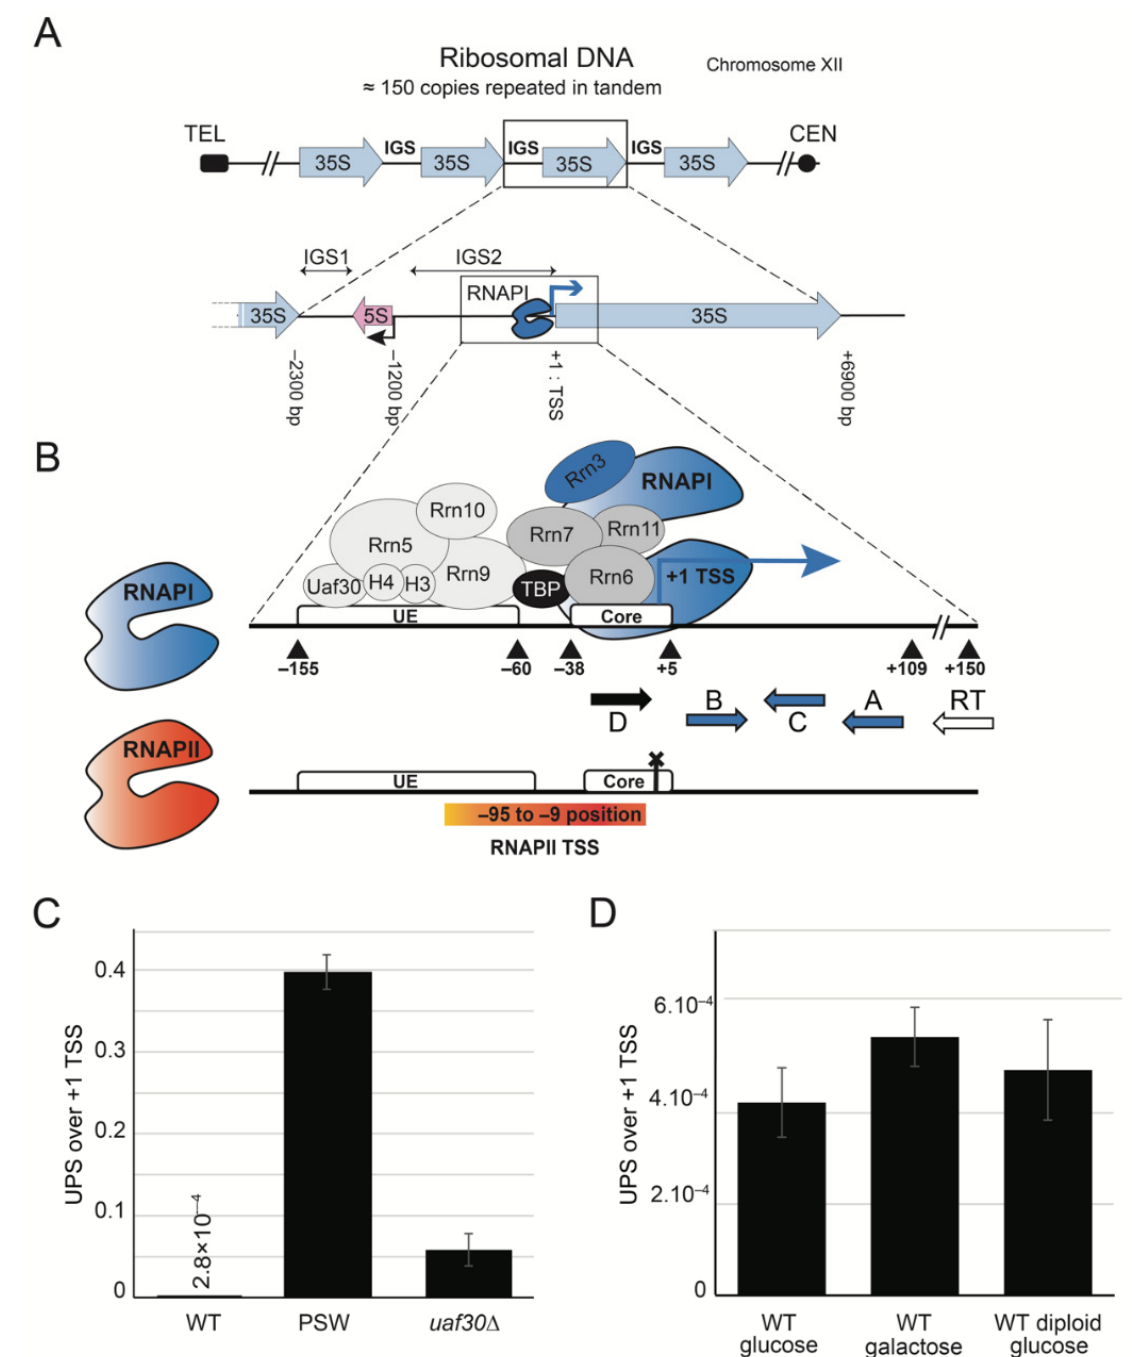
Figure 1. UPS lncRNAs are transcribed from the IGS2 region in rDNA. ( A ) Schematic representation of the rDNA locus in yeast Saccharomyces cerevisiae . The budding yeast contains a single rDNA cluster organized as a linear array of 100–150 rDNA repeats on chromosome XII. Each repeat, of 9.1-kb, produces a 35S precursor rRNA (35S gene is the blue arrow, sequence coordinates are relative to +1 TSS). IGS (intergenic sequence) is separated by the 5S gene (transcribed by RNAPIII, red arrow) into IGS1 and IGS2. ( B ) Details of the 35S promoter region composed of UE (Upstream Element) and core promoter. UE is occupied by the UAF complex (Uaf30, Rrn5, Rrn9, Rrn10, H3, and H4 subunits represented as light grey ovals). Core promoter is occupied by the Core Factor (CF) complex (Rrn6, Rrn7, and Rrn11 represented as grey ovals). UAF and CF are connected by TBP (black ovals). RNAPI bound to Rrn3 (in blue) binds CF bound to the promoter to form the pre-initiation complex. Primers used in experiments are represented below; RT forward primer was used for primer extension and reverse transcription, A-B and C-D couples were used in qPCR. Putative RNAPII (in red) promoter region ( − 95/ − 5) overlapping UE and core is represented as an orange rectangle. ( C ) UPS accumulated in PSW and uaf30 ∆ strains and are present at a very low level in wild-type strain. 1 μ g of total RNA was used for reverse transcription using RT primer. cDNAs were quantified by qPCR using the C-D couple. Detected quantities of 5 ′ -extended transcripts were nor- malized by the values of A-B amplifications corresponding to +1 TSS (+1/109 bp). Error bars correspond to standard devi-